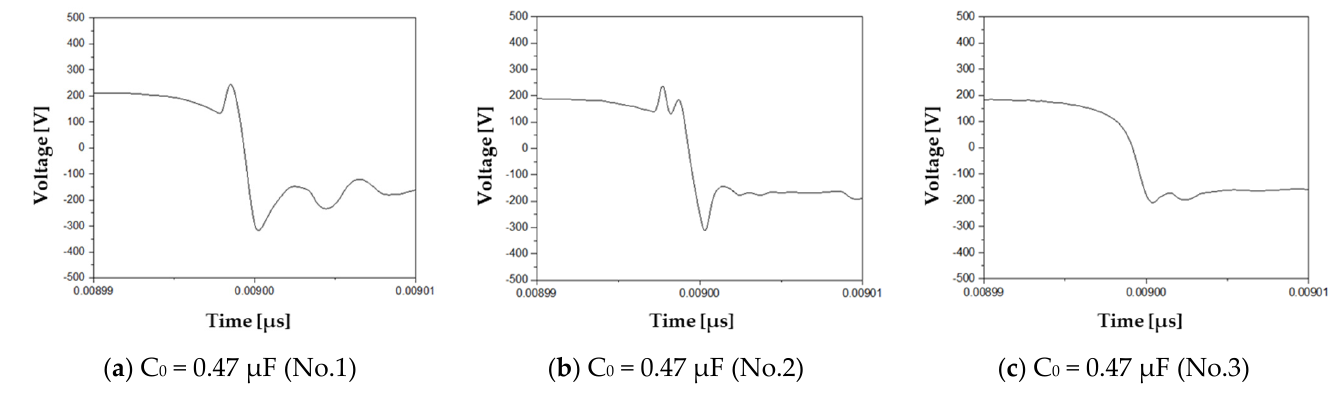
Figure 10. Dielectric recovery voltage at 25 °C.